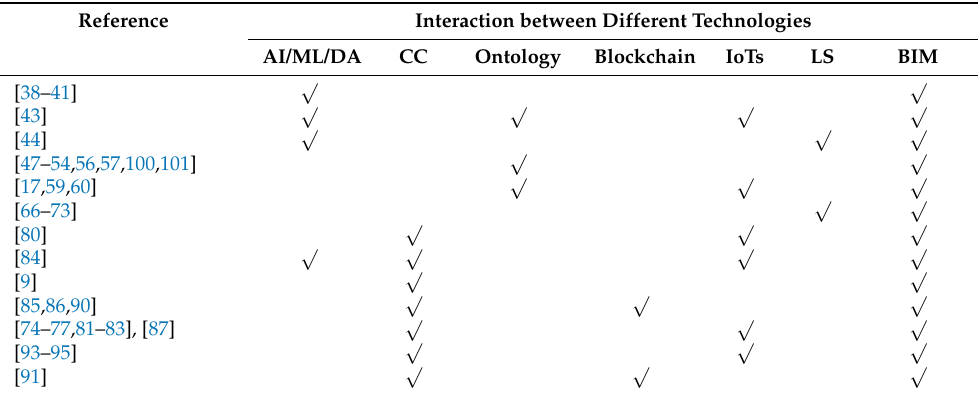
Table 4. Existing works on combining various technologies along with